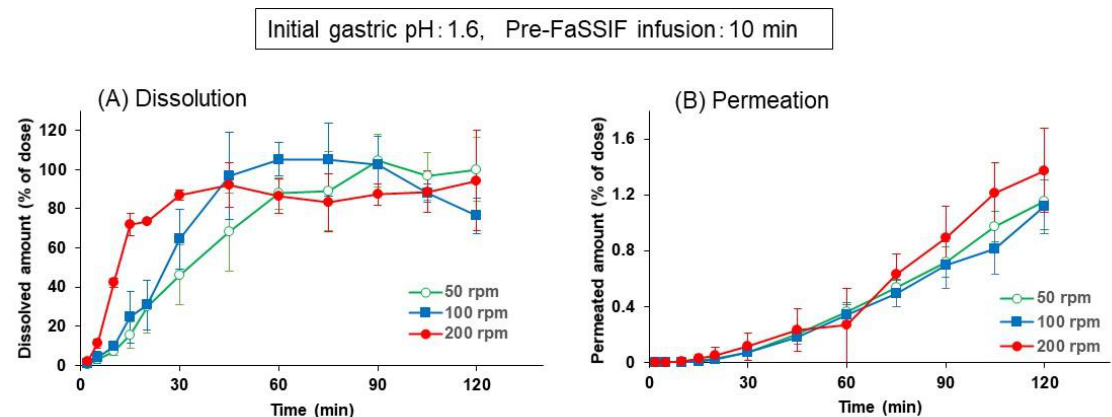
Figure 4. Effect of paddle speed on the dissolution ( A ) and permeation ( B ) time profiles of metoprolol from Seloken ® tablets 20 mg in the BE checker. Each data point represents mean ± S.D. ( n = 3).